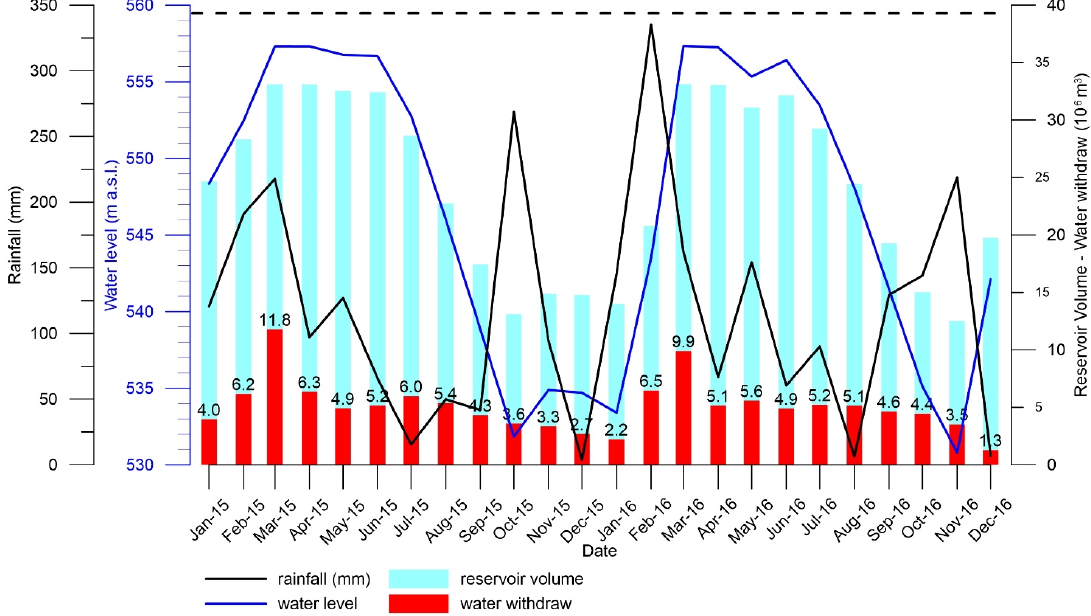
Figure 3. Rainfall (mm) and water level (m a.s.l.) on the left y-axes; reservoir volume and water withdraw (10 6 m 3 ) on the right y-axes in 2015 and 2016. The dash line indicates the surface spillway elevation at 559.60 m a.s.l.